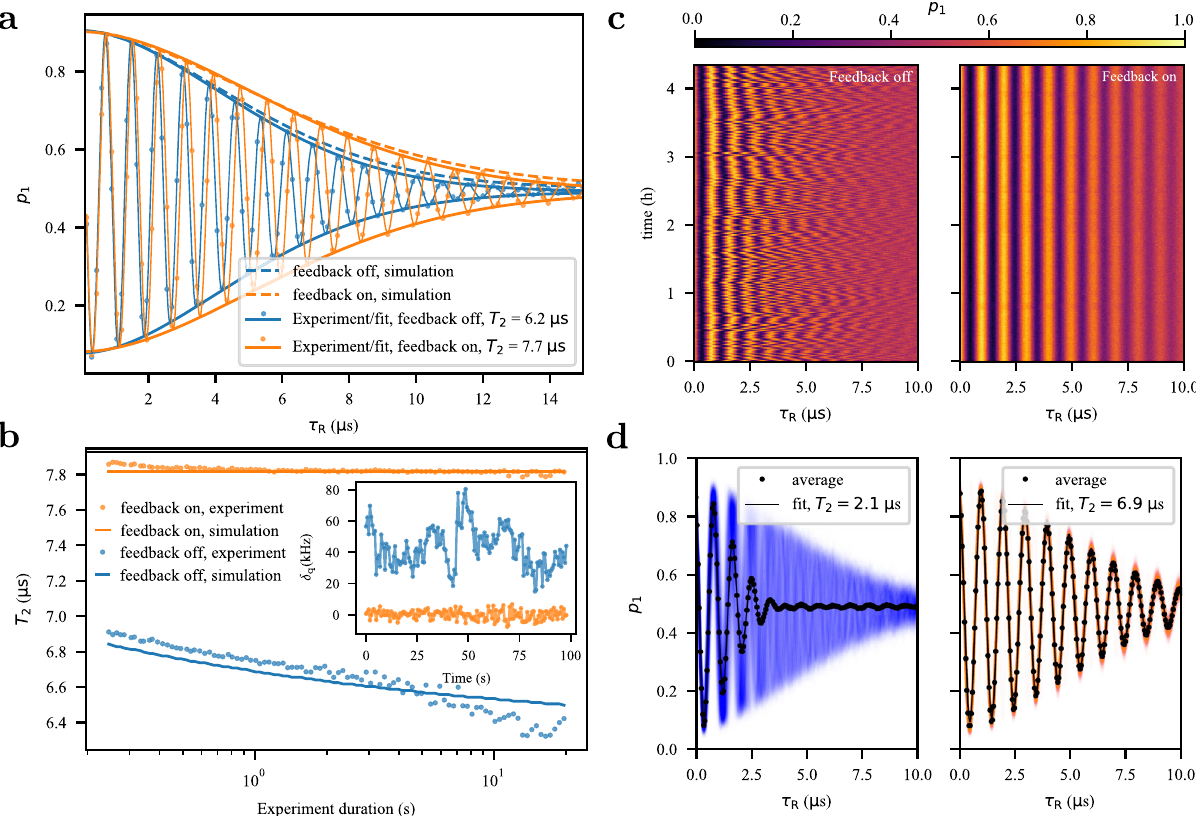
Fig. 2 Improvement in qubit coherence and stability. a The coherence time T 2 of the qubit is measured by interleaving a Ramsey measurement with feedback sequences (orange dots), compared to when the feedback is off (blue dots). The solid lines are a fi t for the data. Dashed lines show a simulation of the decay envelope assuming the noise spectral densities shown in Fig. 1d. b The measured coherence time of the qubit as a function of the duration of the Ramsey experiment is shown with the feedback (orange dots) and without (blue dots). The solid lines are the expected coherence times based on the measured noise spectral density. The inset shows the measured deviation of the qubit frequency from the target frequency during the experiment. Each point is calculated using 50 averages of the Ramsey trace. c shows Ramsey experiment repeated for 4 hours with (right) and without (left) feedback. With the feedback, the qubit frequency is stable during the whole duration. d Averaging the data in ( c ) results in a signi fi cant reduction in qubit coherence if feedback is not used (left). Using the feedback, the inferred coherence is not affected by the measurement duration (right). The coherence time of a single Ramsey trace here is slightly lower than in ( a ) due to the smaller value of τ = 500 ns used in the